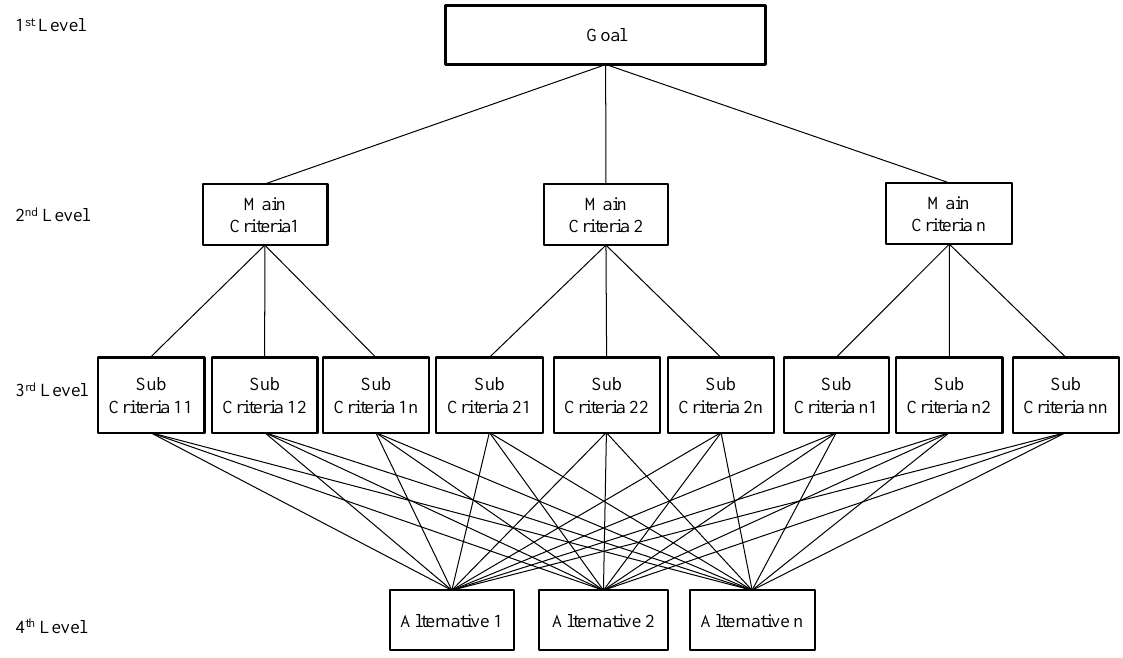
Fig. 1. The hierarchy of AHP